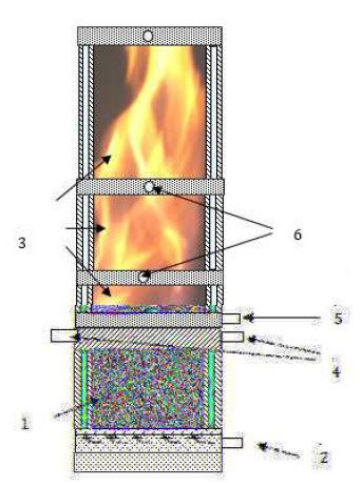
Figure 2. Concentration of CO,H 2 formed at the gasifier outlet vesrus the injection of